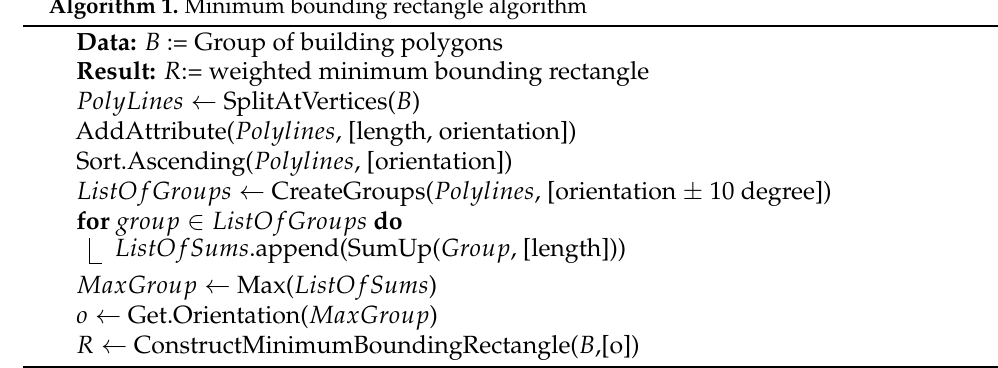
Algorithm 1. Minimum bounding rectangle